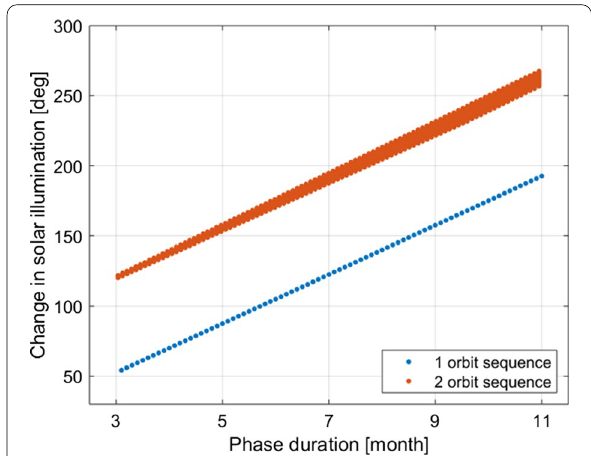
Fig. 18 Approximate achievable change in solar illumination for the case of a single 3:5 resonant orbit (1 orbit sequence) or a combination of 3:5 and 1:1 resonant orbits (2 orbits sequence) as a function of time duration in month. The latter offers different amount of total change depending on how many are flybys performed at each of the two